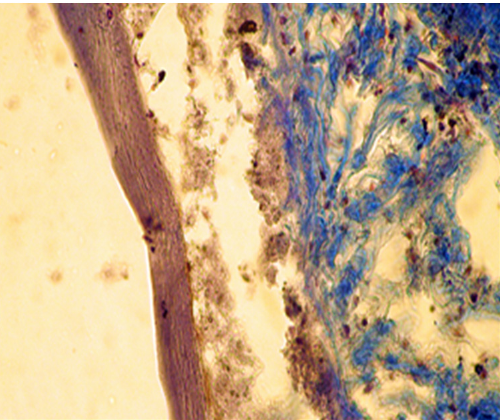
Figure 10. Group C. Moderate necrosis area with pieces of implanted material and moderate leukocyte influx. Partial resorption of the implanted material. Subcutaneous tissue—7 days after implant. Col. Trichrome Masson, ×400 .